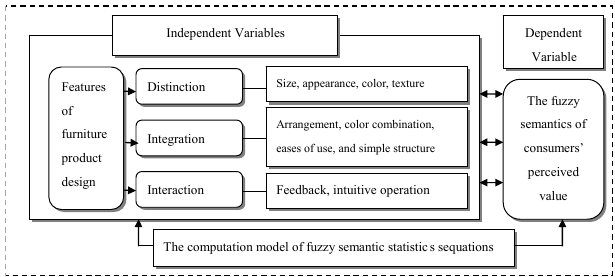
Figure 4: The relational model of the “product design features” of furniture products and the “fuzzy